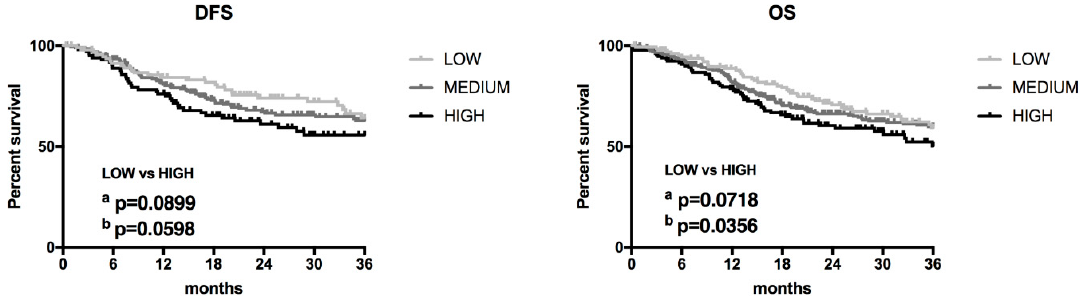
Figure 3. Disease-free survival (DFS) and overall survival (OS) in HNSCC patients with low ( n = 130) and high ( n = 130) expression levels of ZFAS1 ; a—Log-rank (Mantel-Cox) test, b—Gehan-Breslow-Wilcoxon test; p < 0.05 considered as significant.